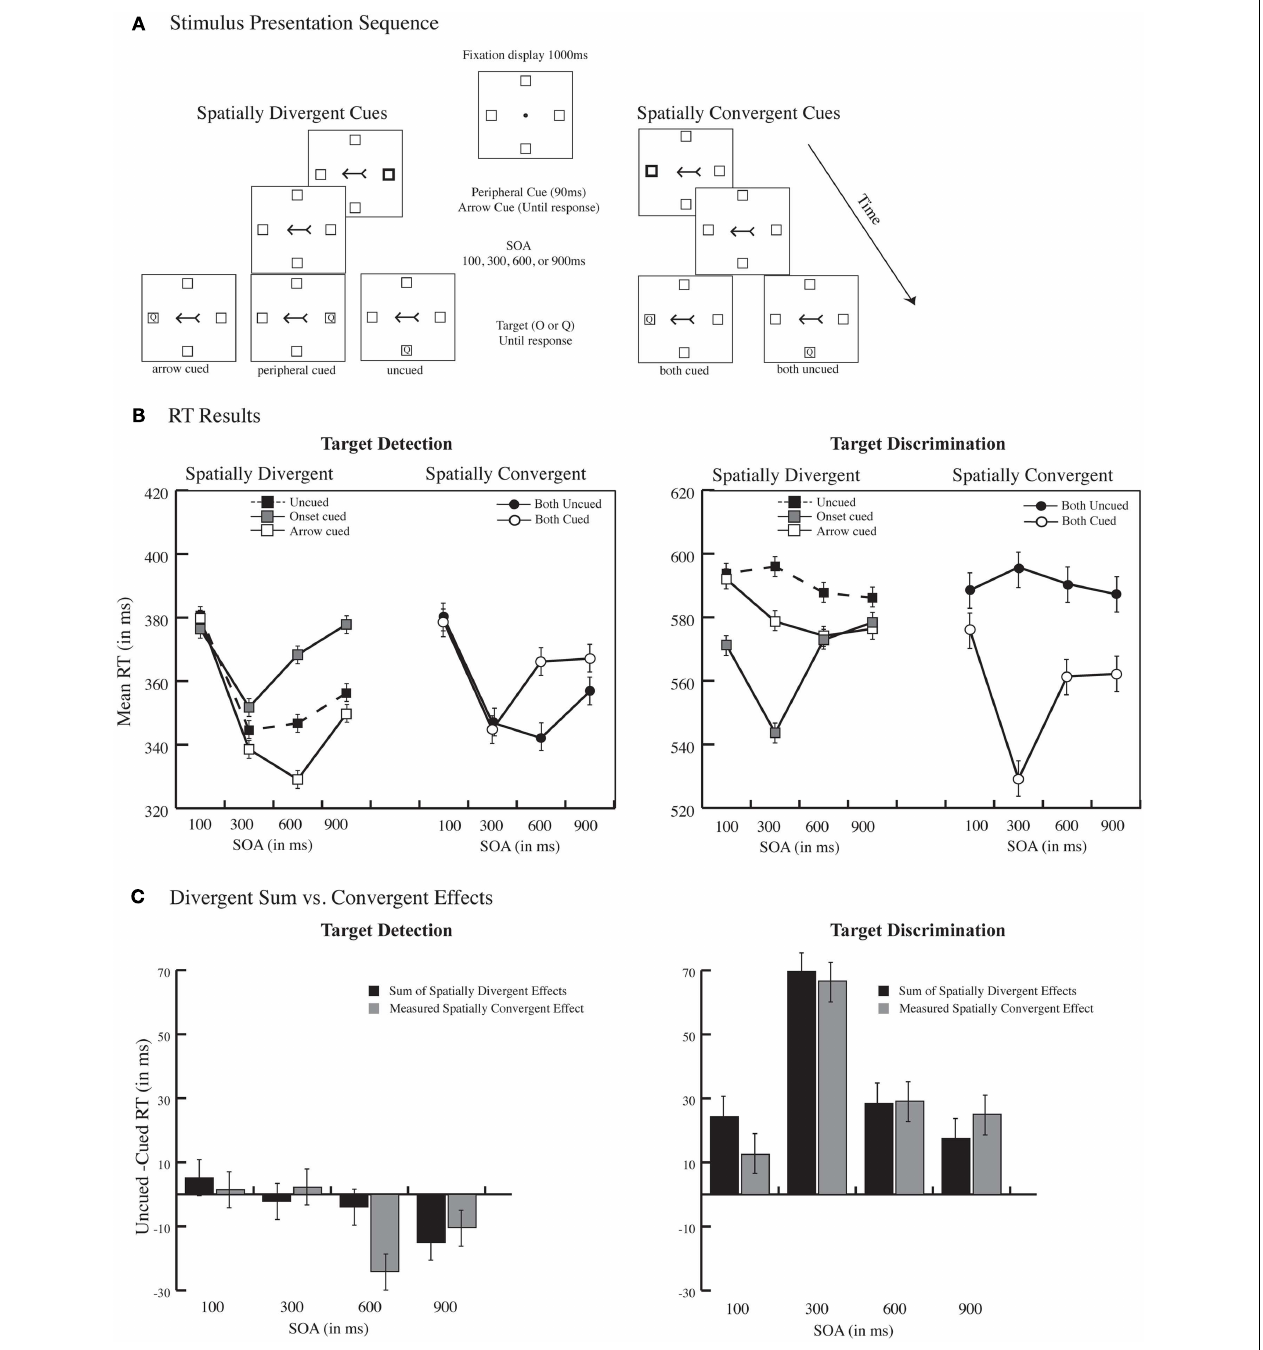
discrimination response, appeared in one of the possible four locations, and remained on the screen until a response. Note that stimuli are not drawn to scale. (B) RT Results. Mean correct RT is plotted as a function of cue position (divergent vs. convergent), cue validity, and SOA for target detection and target discrimination. (C) Divergent sum vs. Convergent Effects.The magnitude of orienting (uncued – cued RT) plotted as a function of SOA when the two cues indicated the same spatial location (convergent cues) and the sum of orienting effects when the two cues indicated different spatial location (divergent cues). Error bars depict the standard error of the difference between the